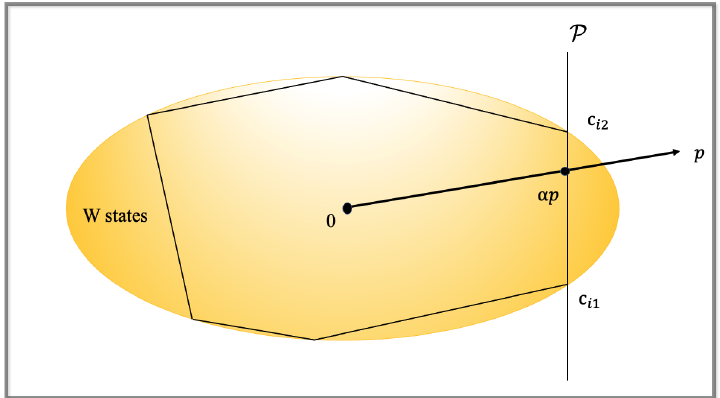
Figure 2. Convex hull approximation. The more critical points there are, the better the approximation